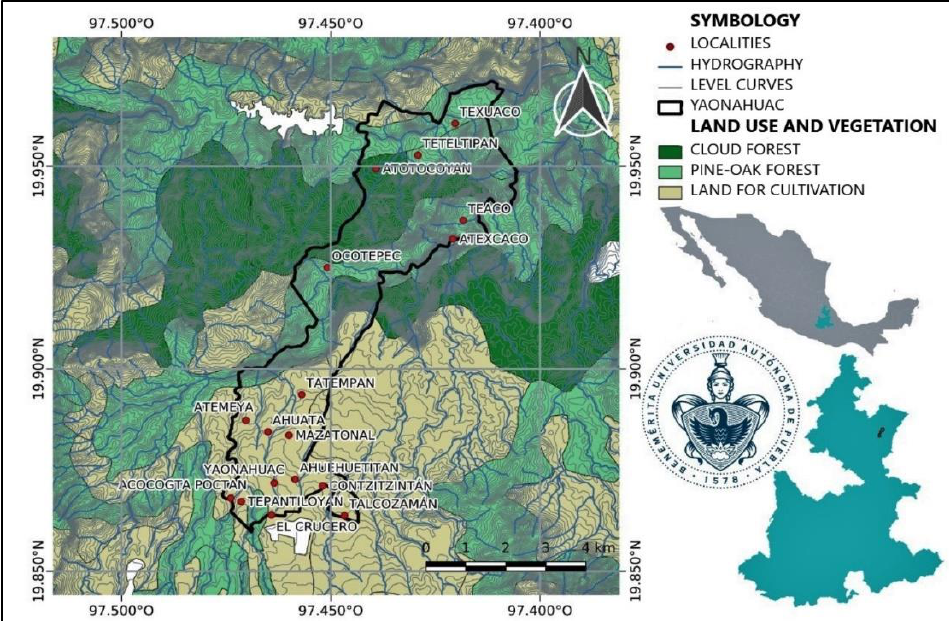
Figure 1. Location and land use and vegetation map of Yaonáhuac, Puebla. Prepared by the au- thors with information from INEGI